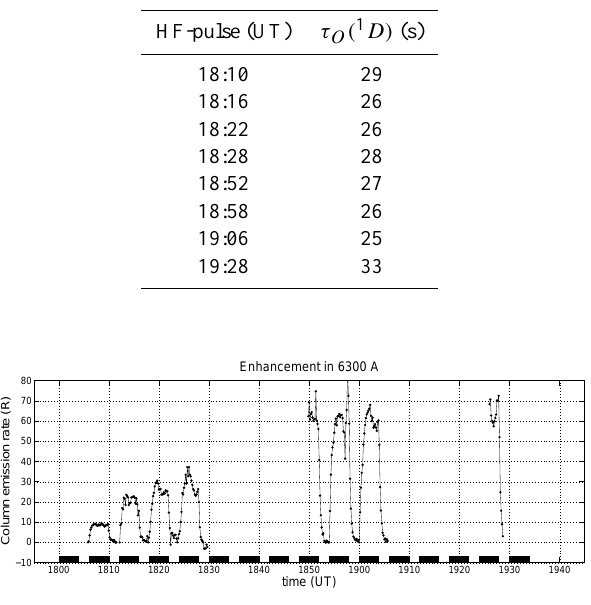
Fig. 3. Maximum enhancements in 6300 ˚A after background reduc- tion. The black squares mark the Fig. 2. Keograms of the ALIS observations after background sub- traction, in the top panel the enhancements in 6300 ˚A, in the second panel 5577 ˚A, in the third 8446 ˚A and in the fourth 4278 ˚A. The scale on the vertical axis is pixel number, the width of the red-line enhancement is approximately 3 ◦ which corresponds to a 15-km width at 250km altitude. The enhancement in 6300 ˚A is 40 ± 3R for the first pulses then, with the rise in altitude and widening of the heated electrons, it increases to 55–70R. For the 5577 ˚A the en- hancement for the first two pulses are 10–15R and then it varies around 10R. For 8446 ˚A the enhancement increases from 10 ± 2 to ( 1 NG) ) emission the enhancements 15 ± 3R and for the 4278 ˚A N + 2 are indistinguishable from the noise for the first pulses but they grow up to 5R at 18:42 UT.